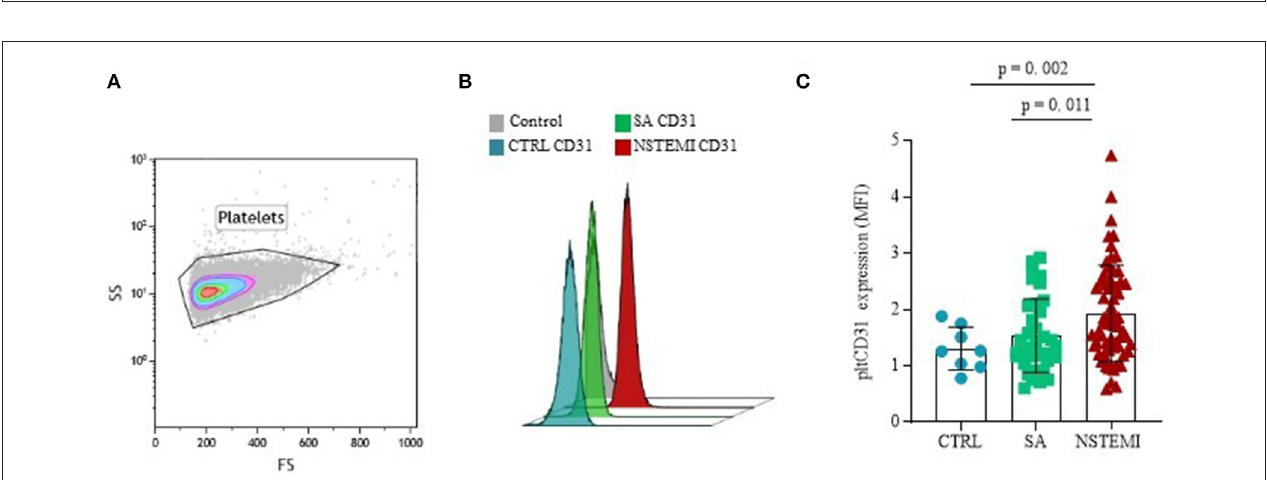
FIGURE 3 | CD31 expression on platelets. Graphs showing the surface protein expression of CD31 on CD42b + platelets assessed by flow-cytometry (mean ± SD), in basal conditions. (A) Representative flow cytometry forward vs side scatter plot of platelets; (B) Representative flow cytometry overlay plot; (C) Data analysis of pltCD31 surface protein expression between the three groups (CTRL, Control individuals; FS, Forward Scatter; MFI, Median Fluorescence Intensity; NSTEMI, Non-ST-Elevation Myocardial Infarction; pltCD31, platelet CD31; SA, Patients with Stable Angina; SD, Standard Deviation; and SS, Side Scatter). (DAPT), age, sex, and risk factors, except for familial history of cardiovascular disease, which is significantly higher in RFC ( p = 0.03, see Table 2 ). Data revealed a decreased, although